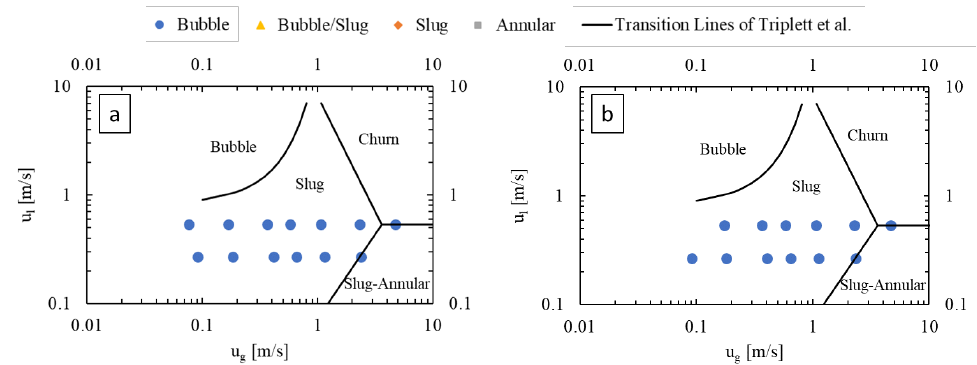
Figure 6. Flow regime maps of ( a ) LL-Rhombus and ( b ) LL-Triangle, with 0.5 wt% aqueous ethanol solution as the liquid phase.